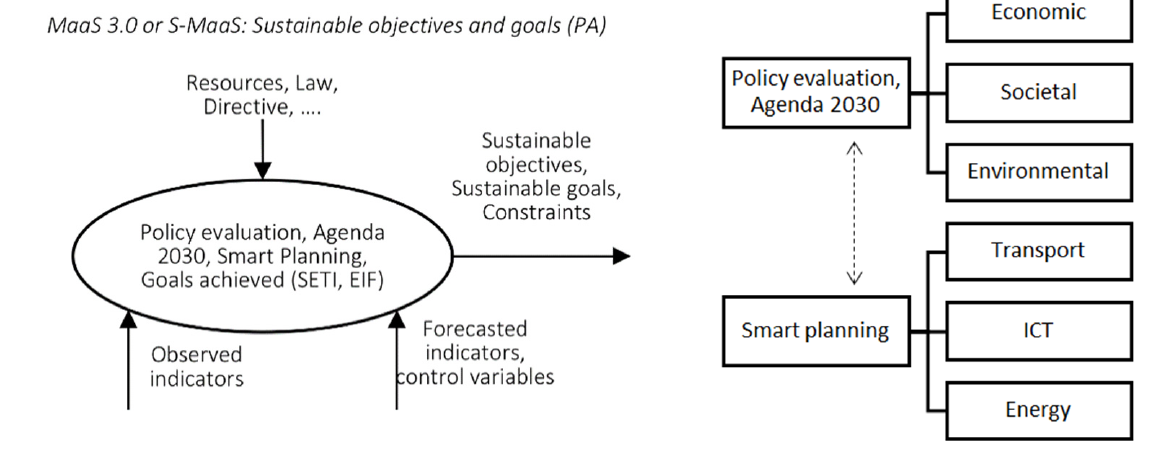
Figure 5. Sustainable objectives and goals and users acceptance (level 3, Sustainable MaaS; level 4, MaaS for Users).